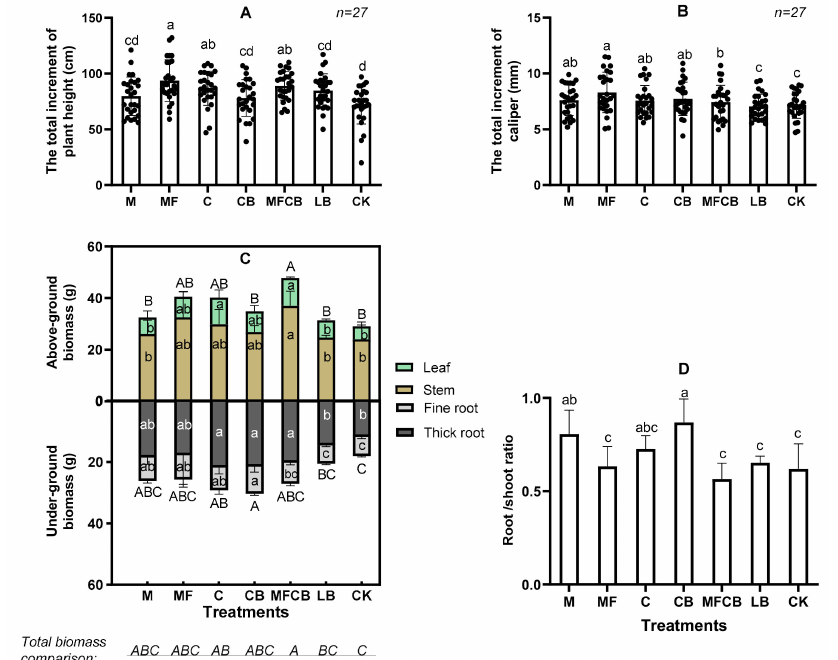
Figure 3. Plant growth, biomass and partitioning of C. paliurus as influenced by inoculants. ( A ): The total increment of plant height. ( B ): The total increment of the caliper. ( C ): Comparison of di ff erent biomass components (leaf, stem, fine root, and thick root) and above / under / total biomass among all treatments; di ff erent lowercase letters inside the bar denote significant variances of biomass component among treatments at p < 0.05; di ff erent capital letters above / under the bar denote significant di ff erences of above / under-ground biomass between treatments at p < 0.05; the comparison of total biomass presented at the bottom. ( D ) Root / shoot ratio was calculated as the ratio of underground biomass to ground biomass. Di ff erent lowercase letters above the bar in A , B , and D denote significant di ff erences among treatments at p <